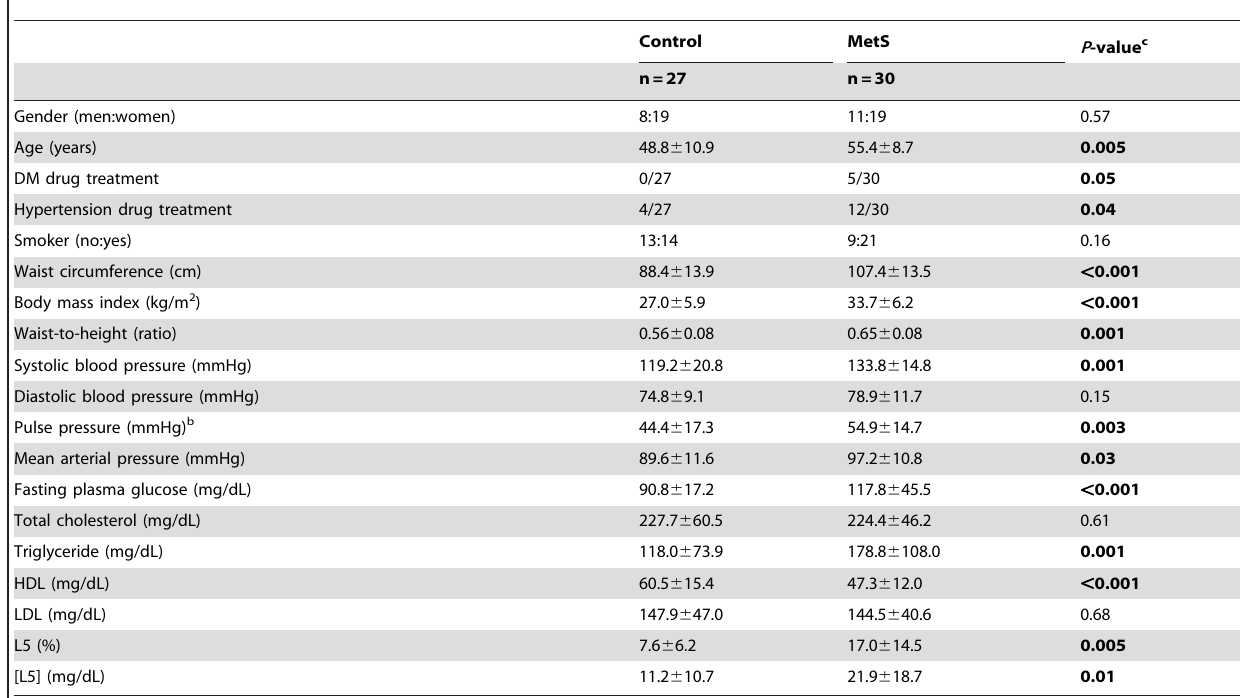
Table 1. Characteristics of MetS and healthy control subjects a